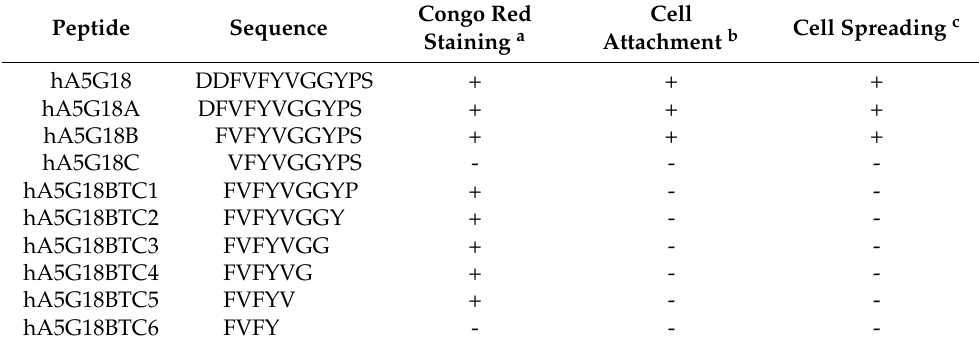
Table 1. Biological activities of hA5G18 and truncated hA5G18 peptides.